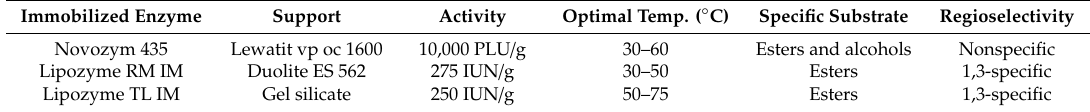
Figure 2. Conversion of octyl formate using commercial lipases. Table 1. Characteristics of commercial lipases [22,23].